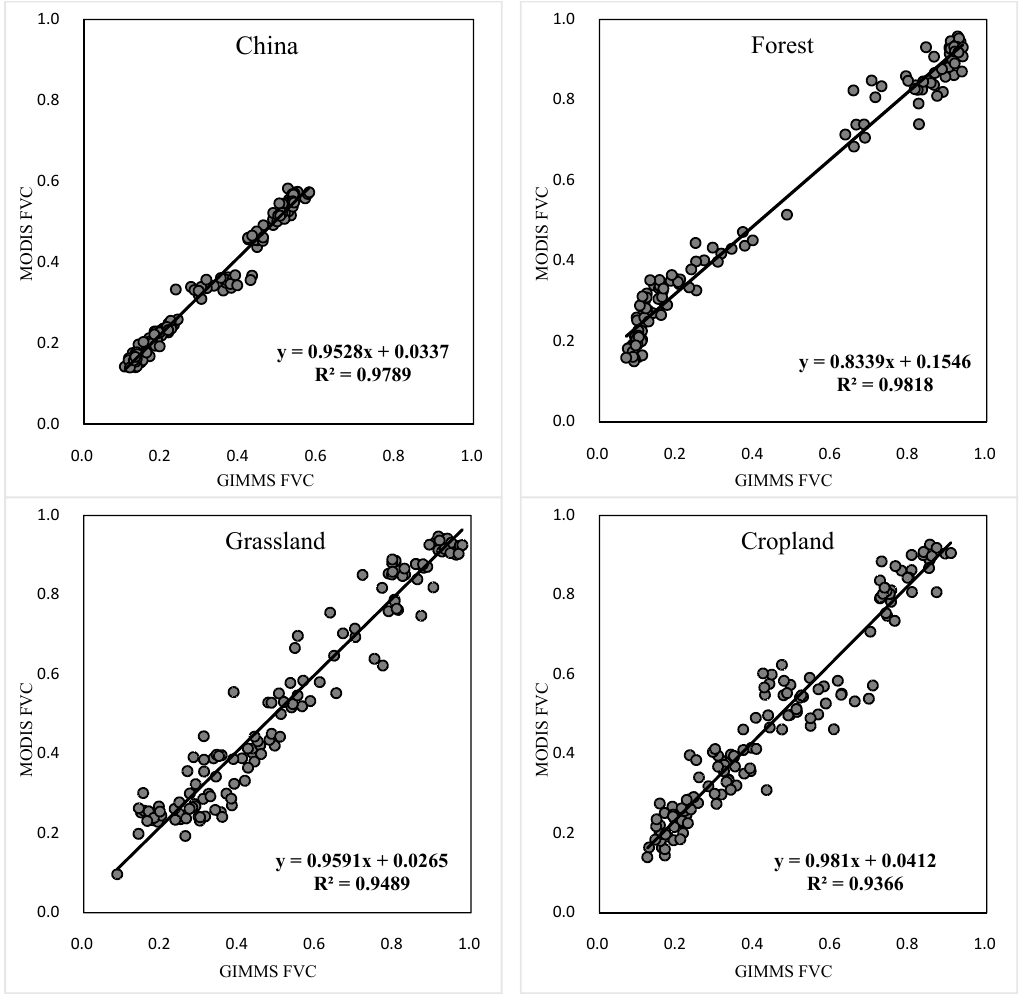
Figure 2. The corresponding scatter plots, including the regression slope, intercept and correlation coefficient between monthly GIMMS FVC and MODIS FVC 2000–2011.